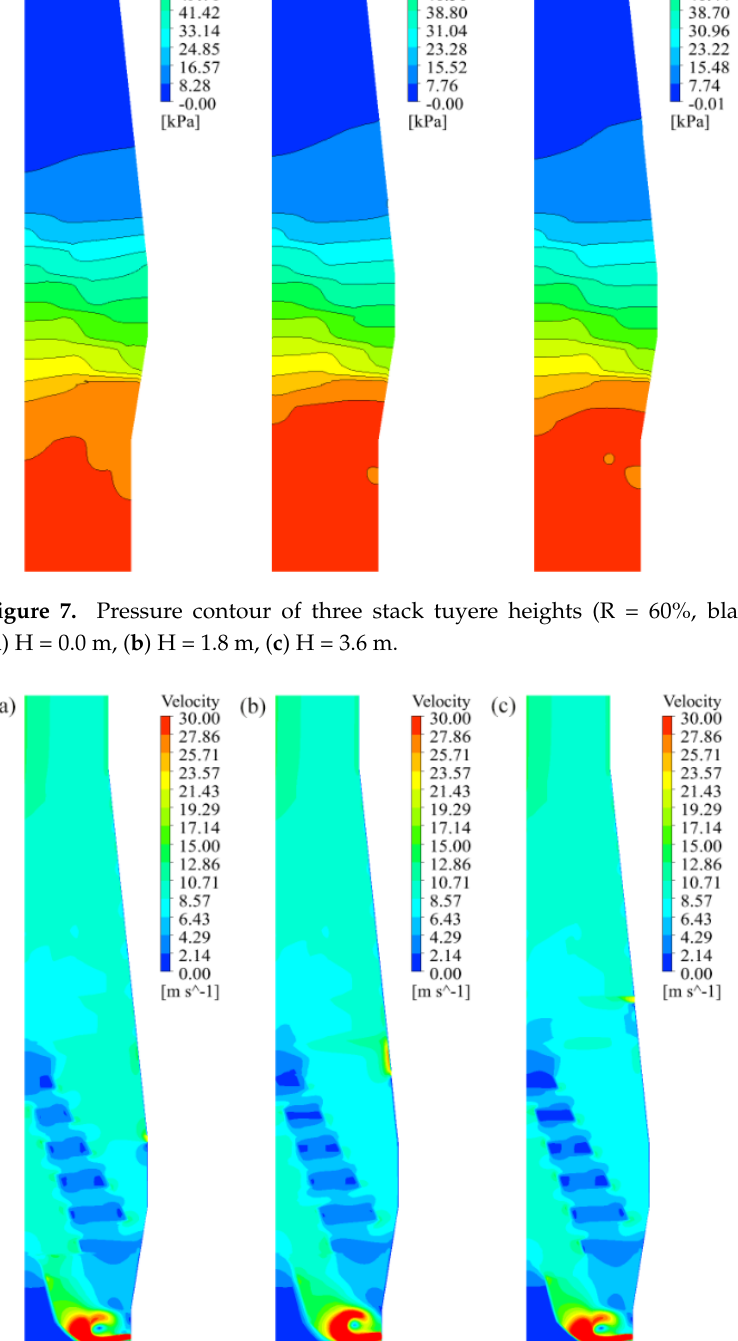
Figure 8. Velocity contour of three stack tuyere heights (R = 60%, blast velocity = 23 m/s): ( a ) H = 0.0 m, ( b ) H = 1.8 m, ( c ) H = 3.6 m.